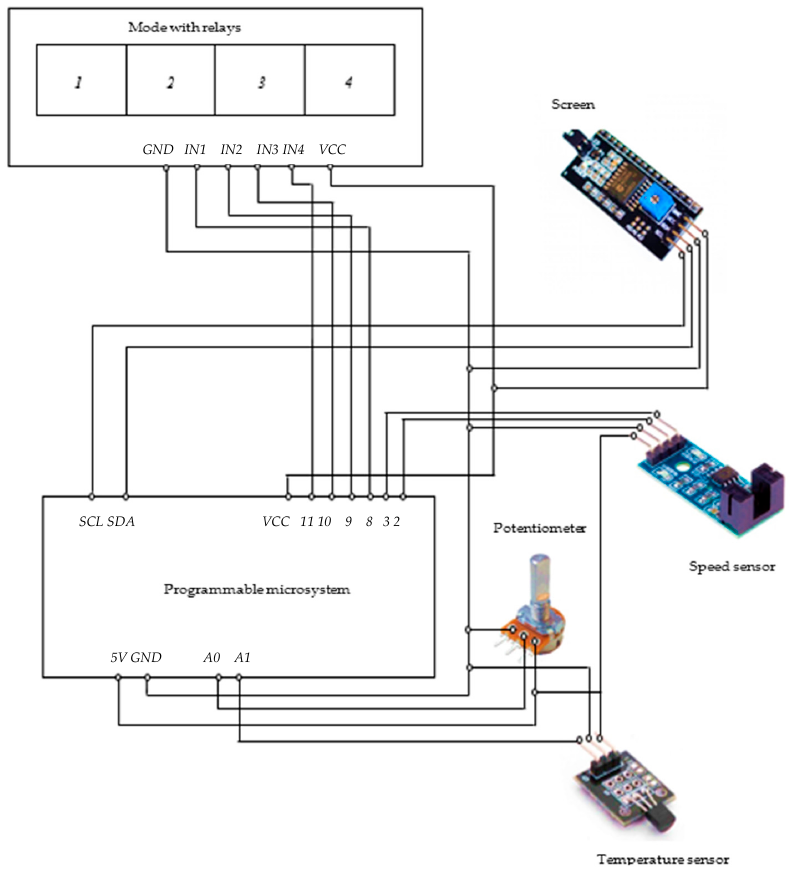
Figure 4. Wiring diagram of the command and/or control